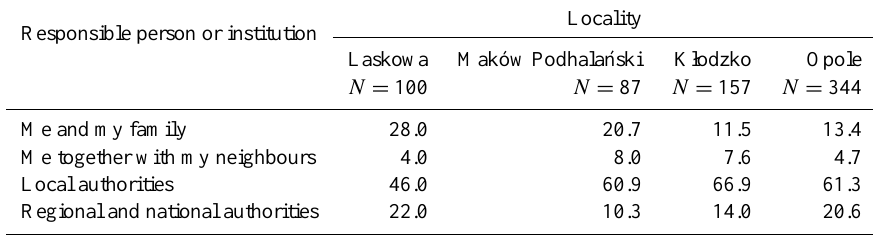
Table 9. Share of the respondents (%) expressing an opinion as to who should be mainly responsible for actions aimed at protecting particular buildings against